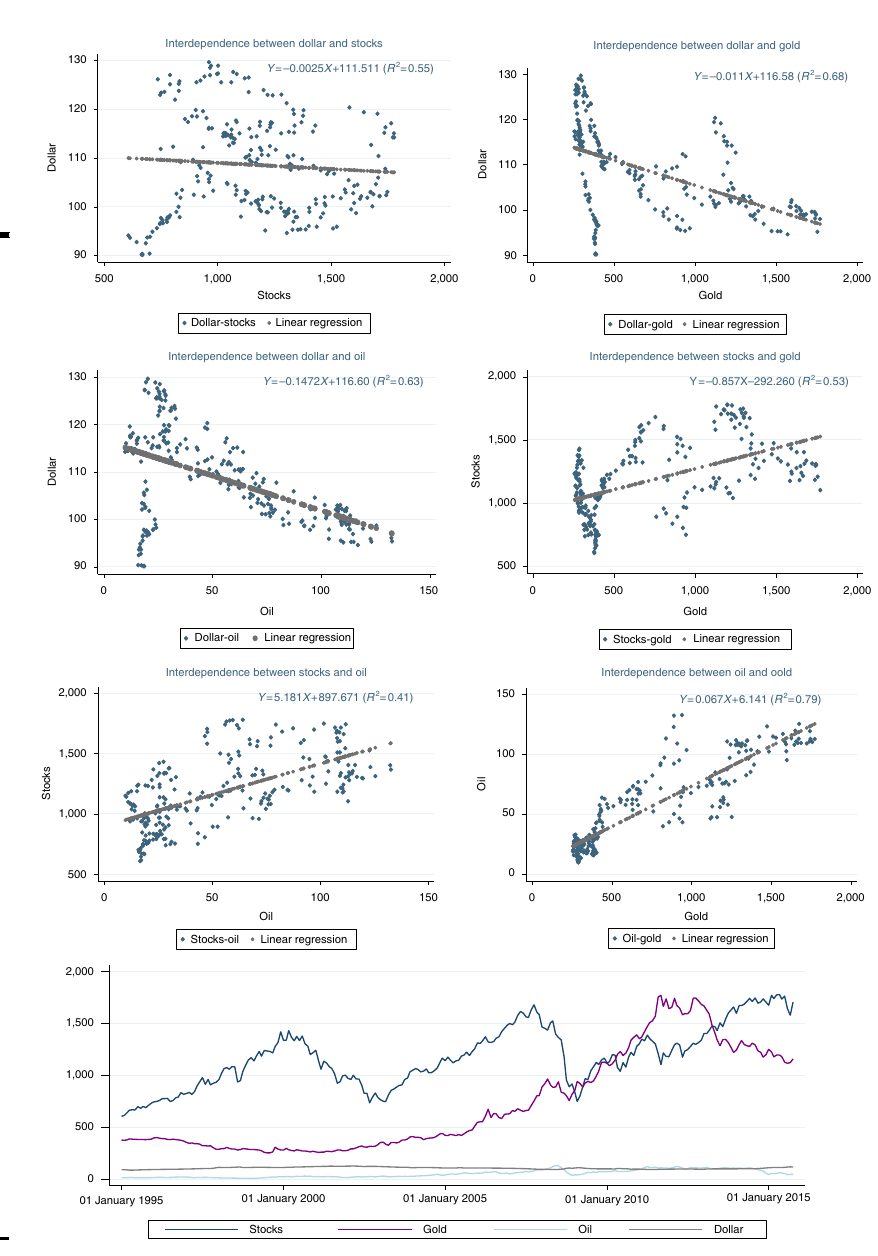
Figure 2. Bilateral interdependencies between the relevant endogenous